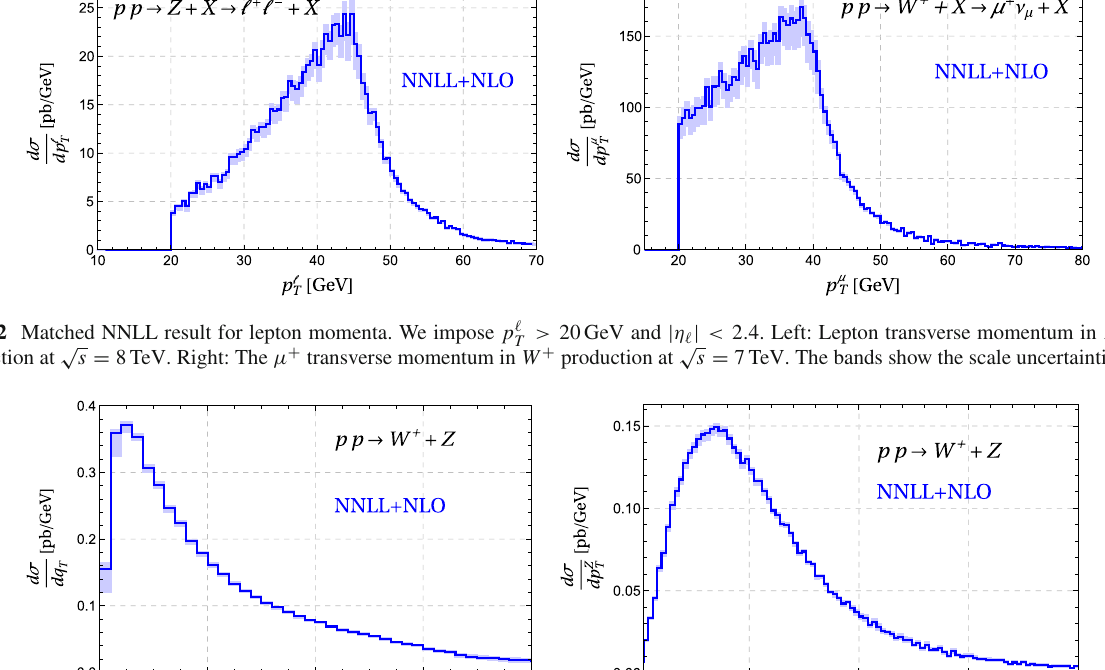
Fig. 13 Matched cross sections for W + Z production at The left plot shows the total transverse momentum q T , the right one p Z , the transverse momentum of the Z boson. The bands show the T